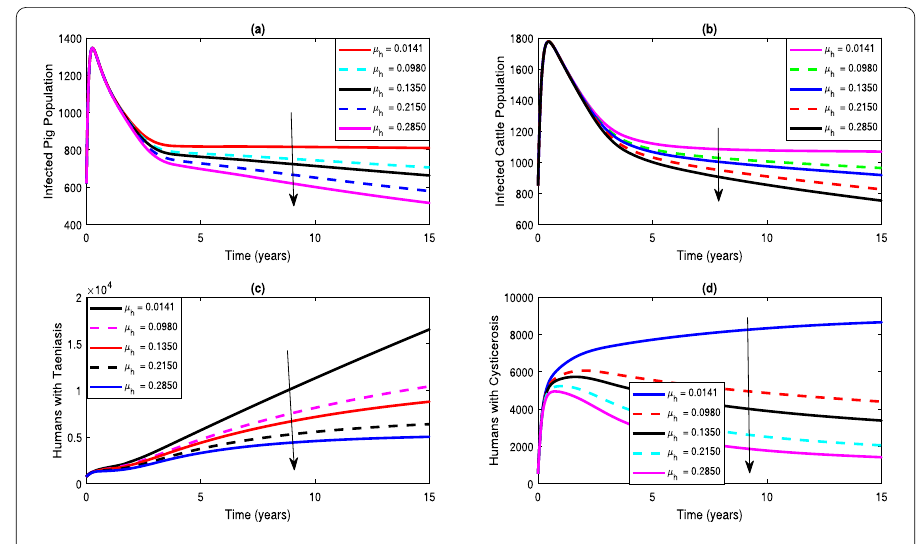
Figure 7 Impact of varying human natural death rate on infected populations